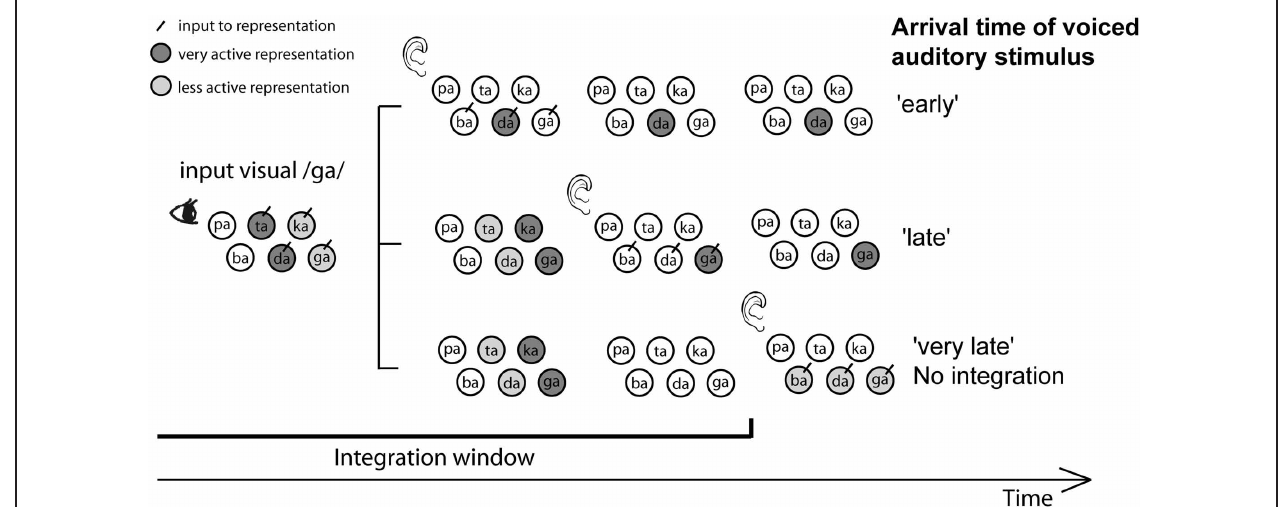
FIGURE 7 | Proposed mechanism explaining the interplay between place of articulation (POA), voicing, temporal integration, and temporal onset cues. The figure shows what happens during the presentation of visual /ga/ and an ambiguous voiced stimulus. For the visual syllable /ga/, POA cues present in the visual signal activate (indicated by darker circles) coronal (/ta/ and /da/) and dorsal (/ka/ and /ga/) representations in a time-dependent manner: the activation decays over time (indicating the TWI), and depending on the natural audio-visual onset differences, maximal activation occurs at different time points for the two POAs (later for dorsal than for coronal). Therefore, the time when auditory